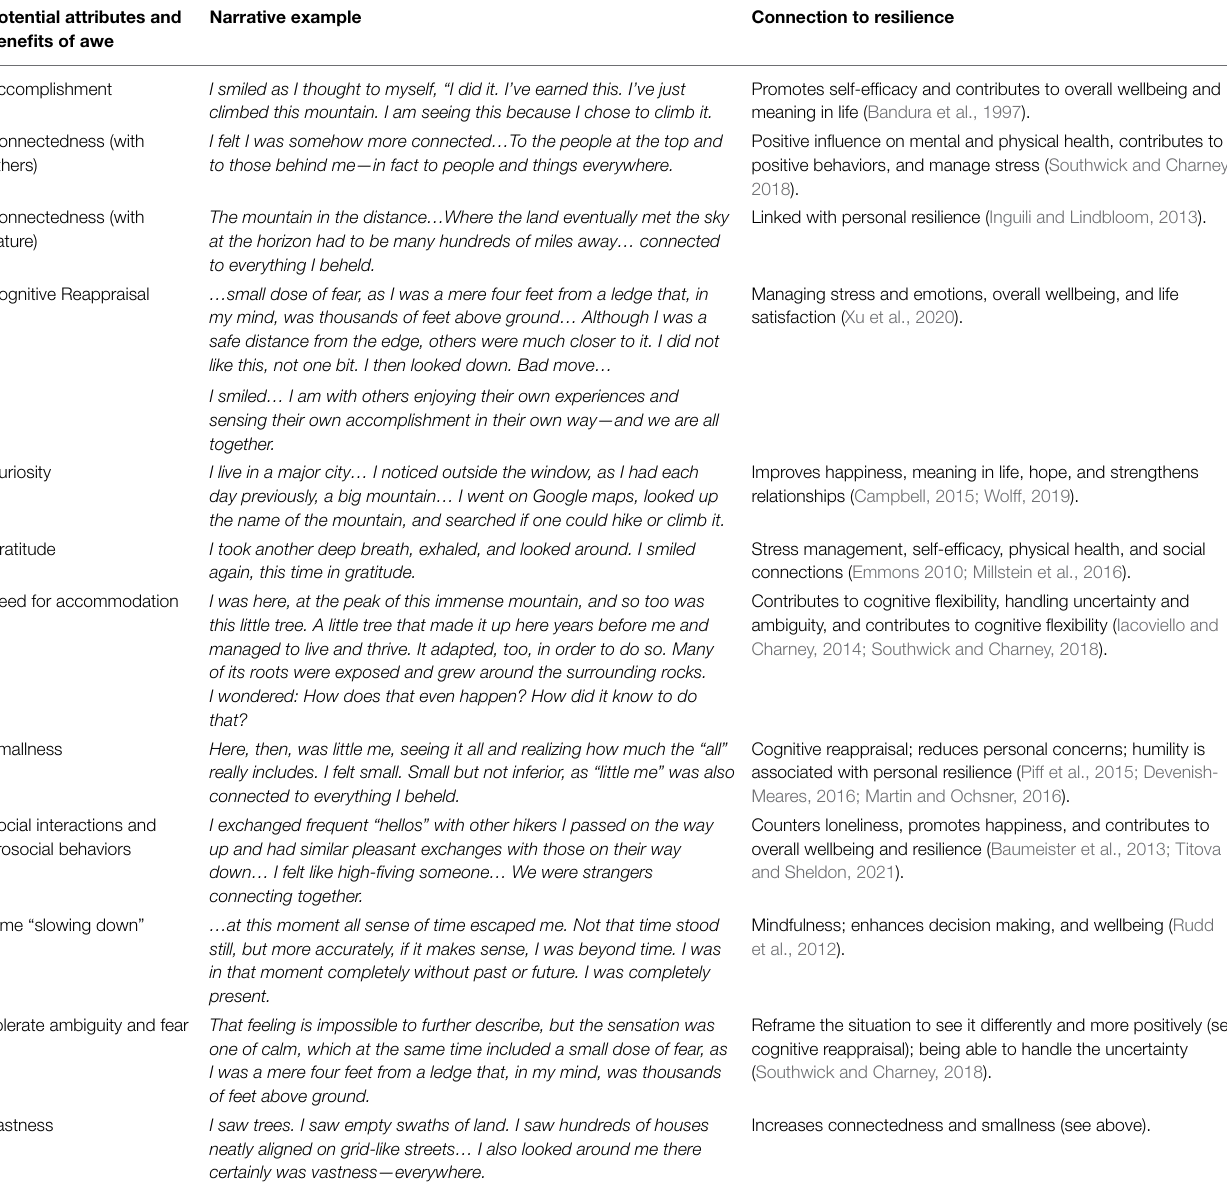
TABLE 1 | Awe: Linking the research with the narrative and